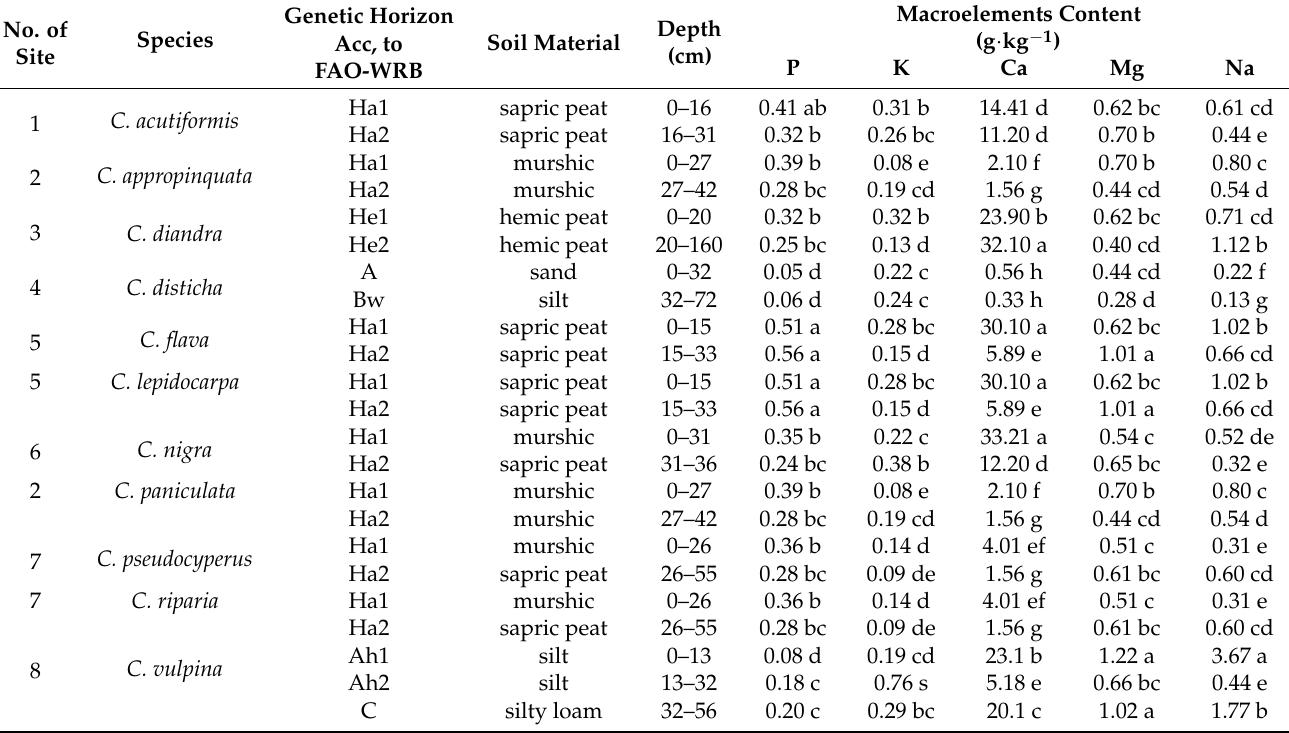
Table 2. Total content of macroelements in the examined soils. The same letters indicate a lack of statistically significant differences among species analysed according to Tukey’s